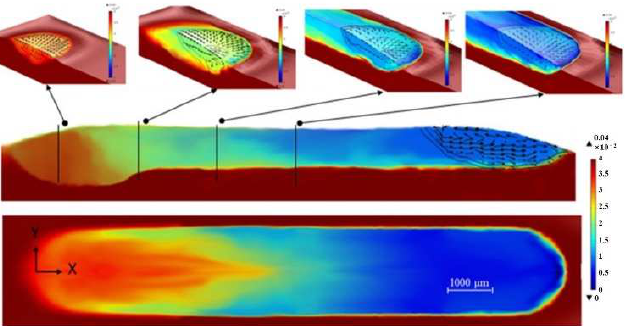
Figure 3. Sulfur concentration profile and melt pool depth distribution in the longitudinal section [54].